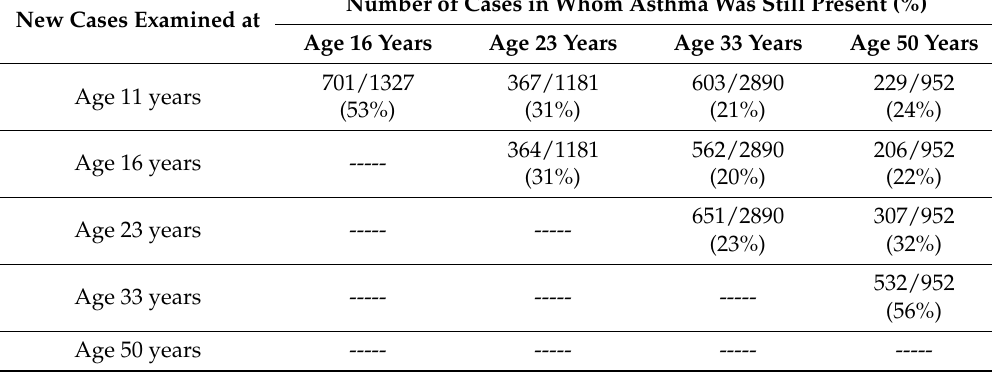
Table 4. Follow-up data of individuals with asthma/wheezing or bronchitis according to age of